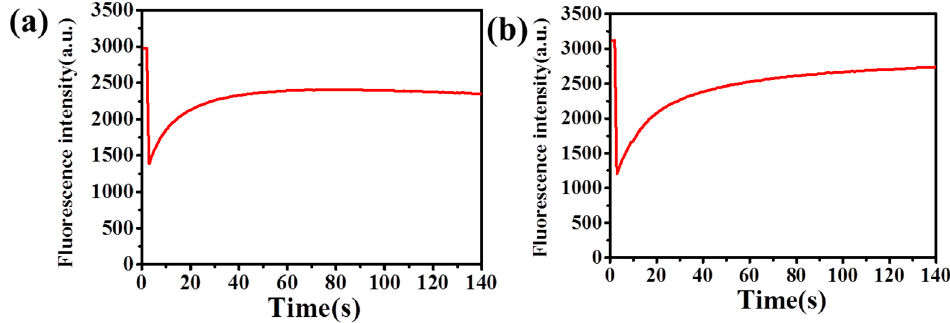
Figure 2. The schematic representations of the FRAP experiments on fluoresceinisothiocyanate (FITC) ( a ) the FRAP image of pure HA (3 wt.%), ( b ) the FRAP image of HA-CD (3 wt.%, grafting rate 4.71%).